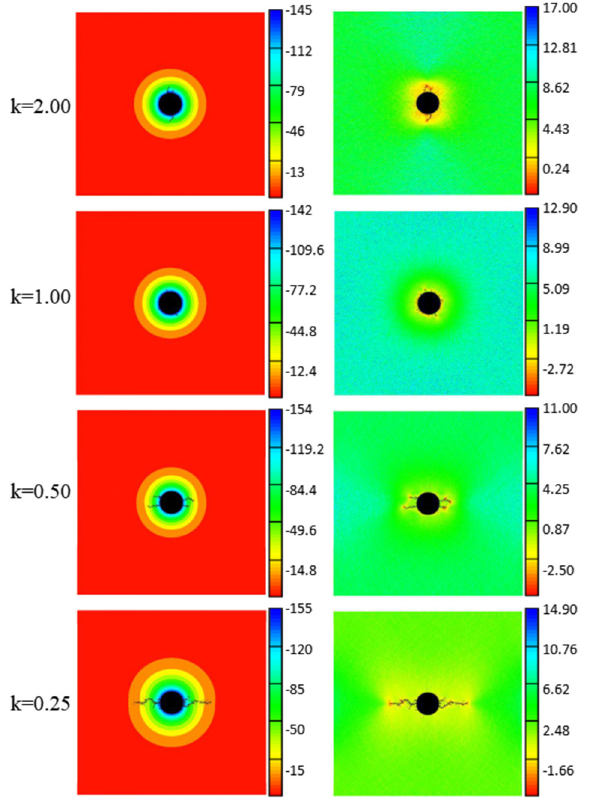
Figure 21. Effect of different lateral stress coefficients on temperature, minimum principal stress distribution, and crack propagation of the circular hole model under liquid nitrogen impact (unit: MPa).